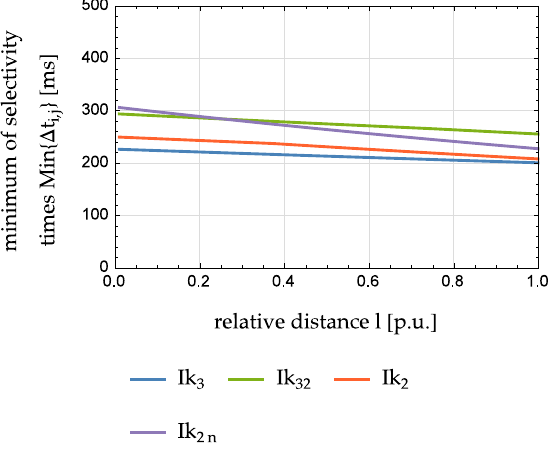
Figure 15. Dependence of the minimum selectivity times Min { ∆ tm i,j } on relative distance l for radial power system where all required short-circuit types are considered.